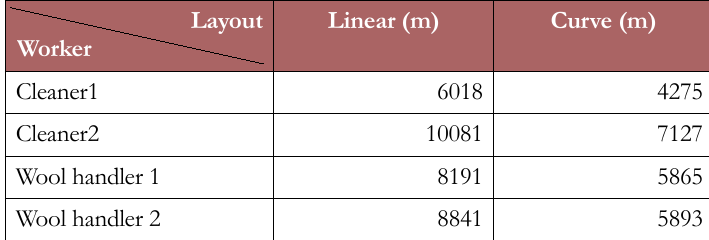
Table 3. Travelled distances by workers in each